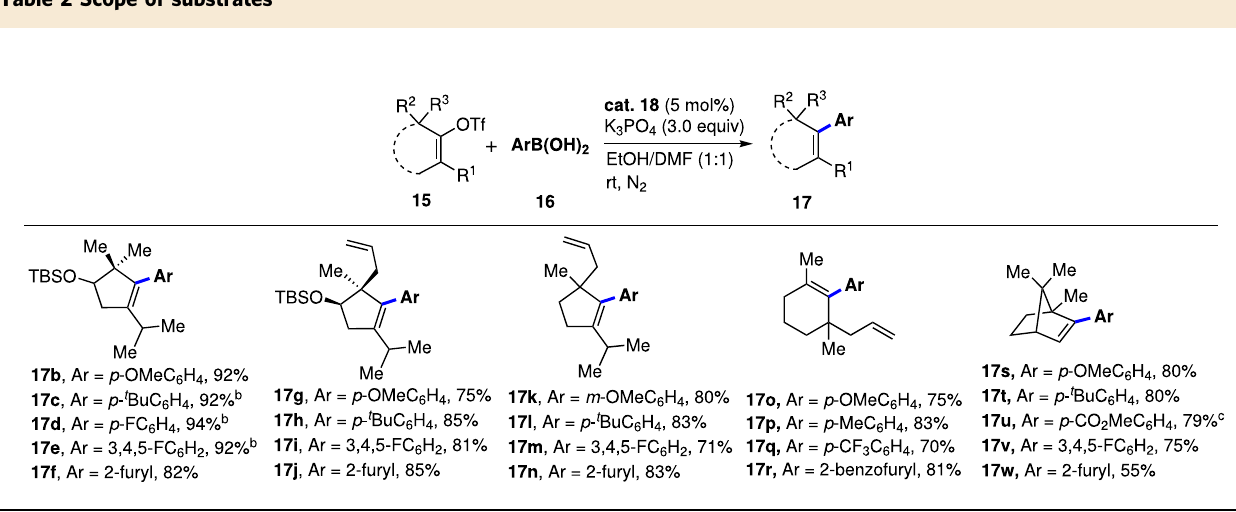
Table 2 Scope of substrates a